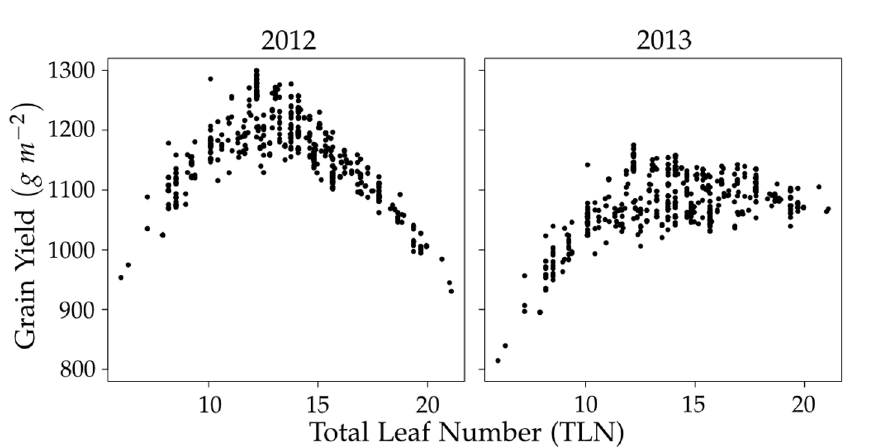
Fig 4. Relationship between total leaf number (TLN) and grain yield. Results shown are from a representative example data